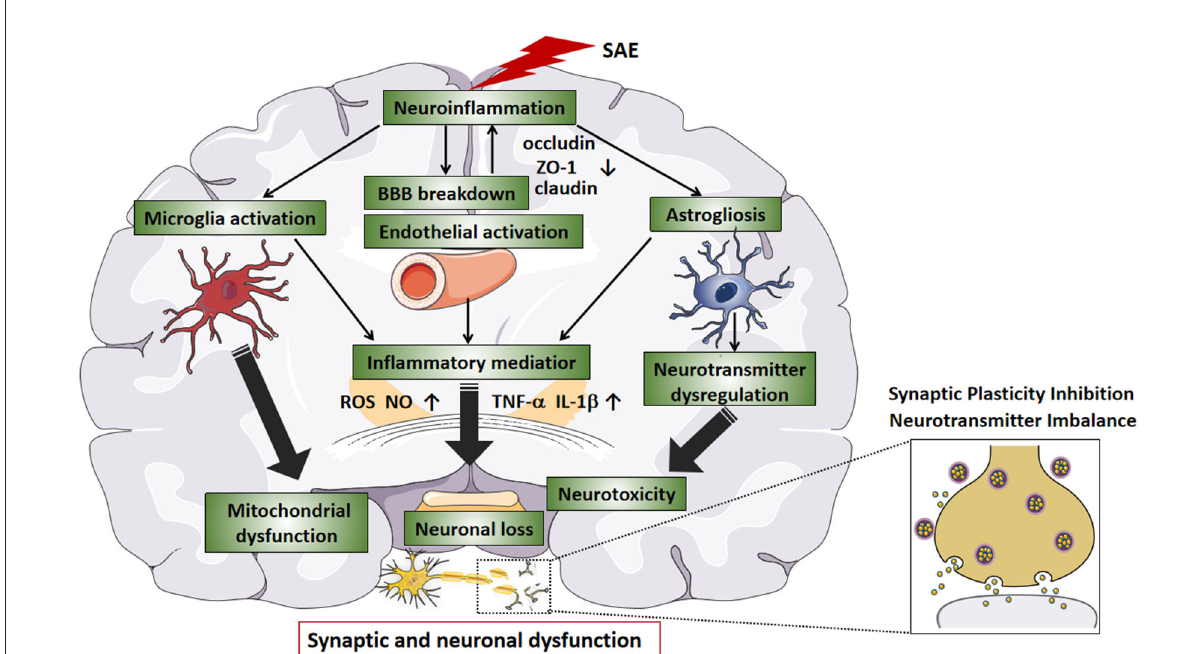
FIGURE1 The pathophysiological mechanisms in SAE. Neuroinflammation is considered to be the main indicator of SAE. During SAE, downregulation of tight junction proteins (e.g., occludin, ZO-1, and claudin) marks BBB disruption. As the BBB breakdown, intravascular material leaks outside the blood vessels, causing cerebral edema and reduced microvascular perfusion, which leads to neuronal loss. In addition, the release of large amounts of inflammatory factors (e.g., TNF-a and IL-1b) leads to an acute inflammatory response and activates endothelial cells, producing ROS and NO, further increasing BBB permeability. Endothelial injury causes abnormal cellular metabolism, oxidative stress, and disturbance of brain perfusion, leading to ischemia. After SAE, hyperactivation of microglia can further exacerbate the inflammatory response, and BBB leakage, and participate in the progression of brain dysfunction. Activated astrocytes produce pro-inflammatory cytokines that exacerbate neuroinflammatory responses, produce excitotoxicity, and lead to neuronal death. SAE-induced dysfunction of the vascular complex (including endothelial cells, astrocytes, and BBB) and activation of microglia can exacerbate neuroinflammation, increase neurotoxicity and hypoxia and lead to mitochondrial dysfunction, thereby exacerbating neurological damage. In SAE, the interaction between neuroinflammation, glial cell activation, and BBB injury ultimately affects synaptic and neuronal dysfunction. SAE, sepsis-associated encephalopathy; BBB, blood-brain barrier; TNF-a, tumor necrosis factor-alpha; IL-1b, interleukin-1b; ROS, reactive oxygen species; NO, nitric